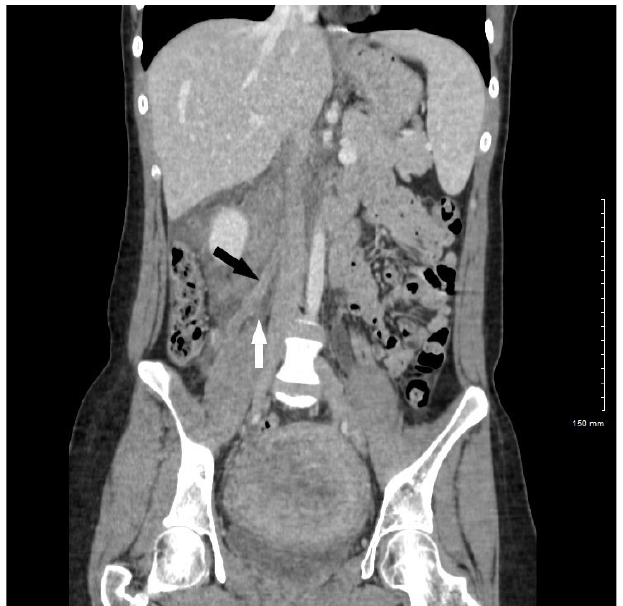
Image 1. Contrast-enhanced coronal computed tomography image showing tubular enhancing structure along the expected course of right ovarian vein (black arrow) with surrounding fat stranding (white arrow).